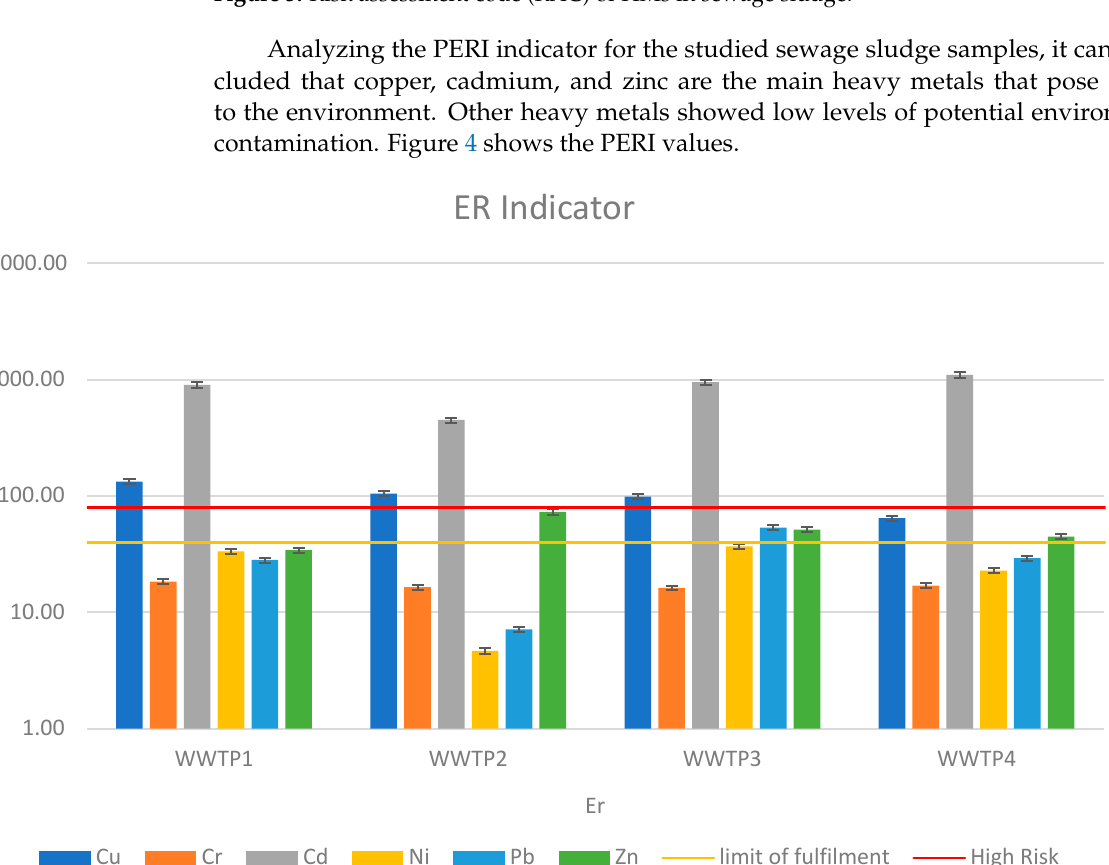
Figure 4. PERI indicator of heavy metals in sewage sludge.